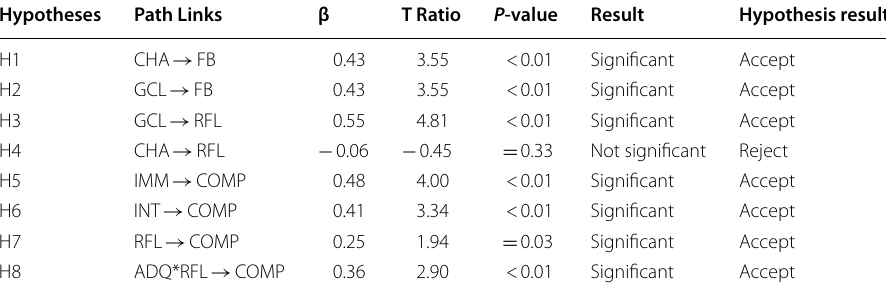
Table 5 Standardized path coefficient for tested model Hypotheses